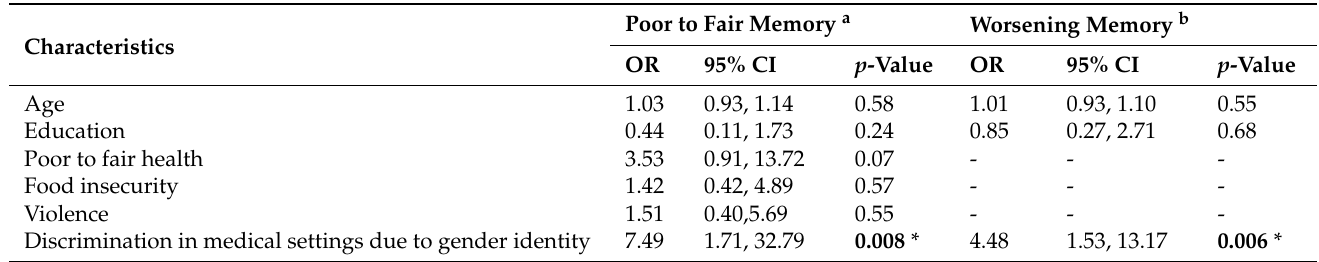
Table 4. Logistic Regression Models Examining Association Between Discrimination in Medical Settings and Subjective Cognitive Decline in Transgender and Nonbinary Older